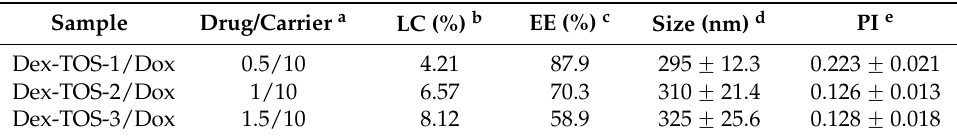
Table 1. Physicochemical characteristics of Dex-TOS/Dox micelles.